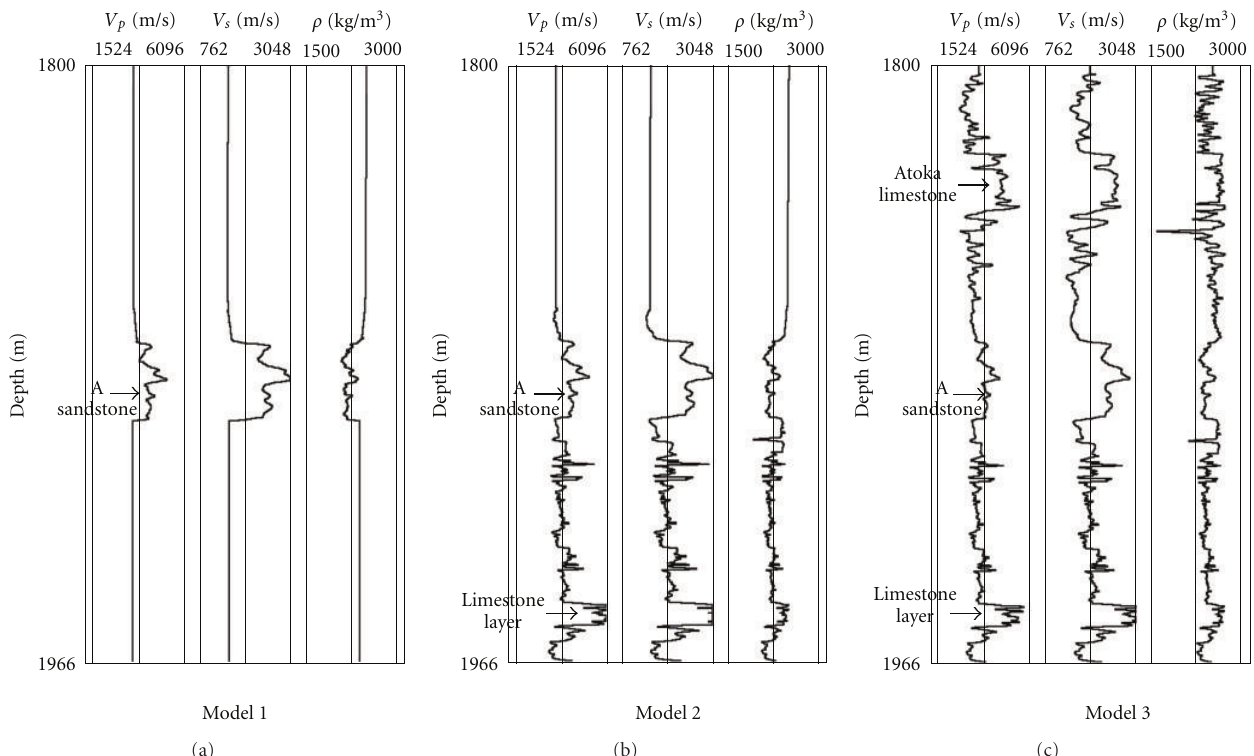
Figure 5: The three di ff erent 1D models used to understand the Morrow A sandstone response on synthetic gathers. Model 1—only Morrow A sandstone interval, Model 2—Morrow A sandstone with one limestone layer below, and Model 3—Morrow A sandstone with Atoka limestone above and one limestone layer